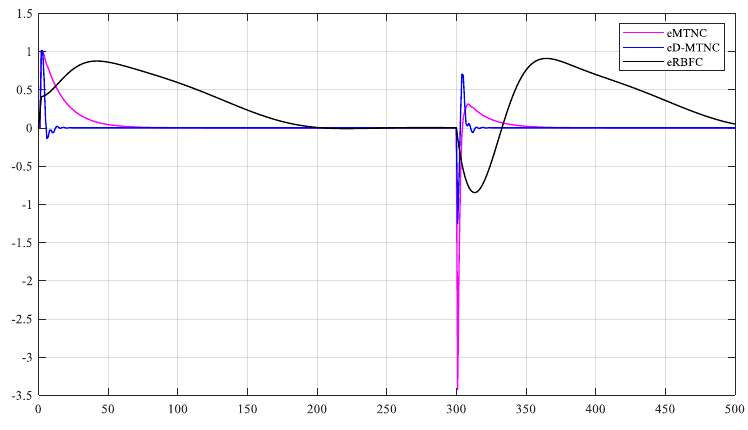
Figure 7. The tracking error with noise.